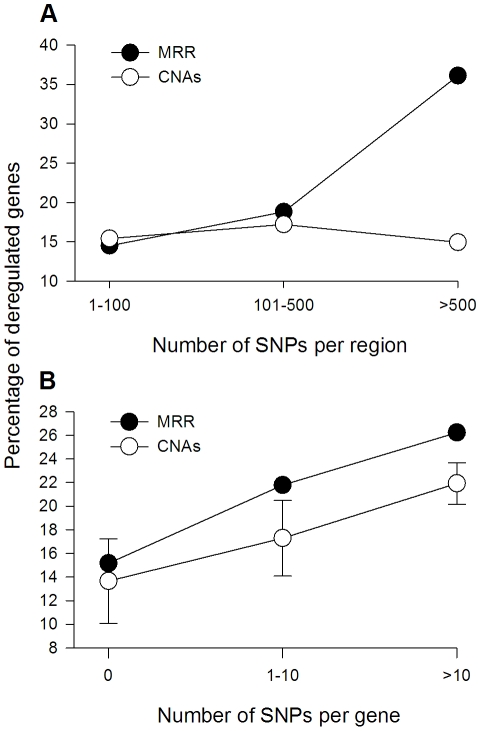
Trend of deregulated genes as CN-altered SNPs increased by gene or region.The figure shows the percentage trends of deregulated genes as the number of CN-altered SNPs per region (panel A) or gene (panel B) increased. MRR includes the genes harbored by the minimal recurrent regions common to the 4 cell lines. The linear association between the variables in all but one plot (CNAs, panel A) was statistically significant, p<0.01, Mantel–Haenszel linear-by-linear association chi-squared test.